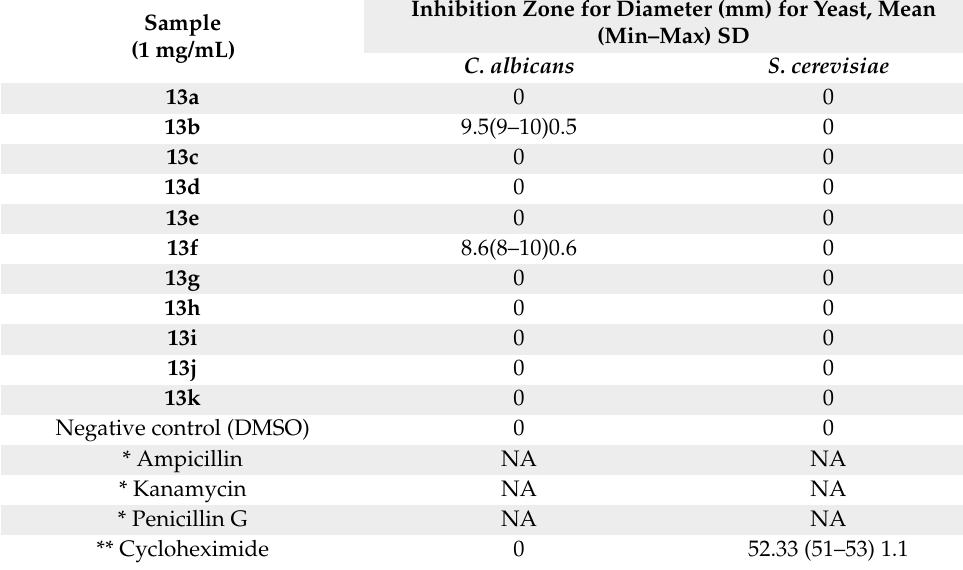
Table 4. Diameters of the inhibition zones for the tested compounds against yeast.